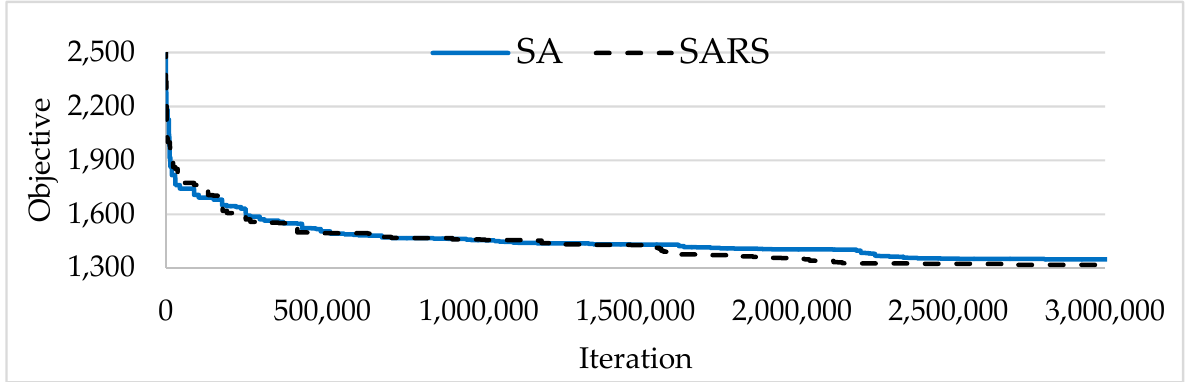
Figure 6. Convergence history of SA and SARS .